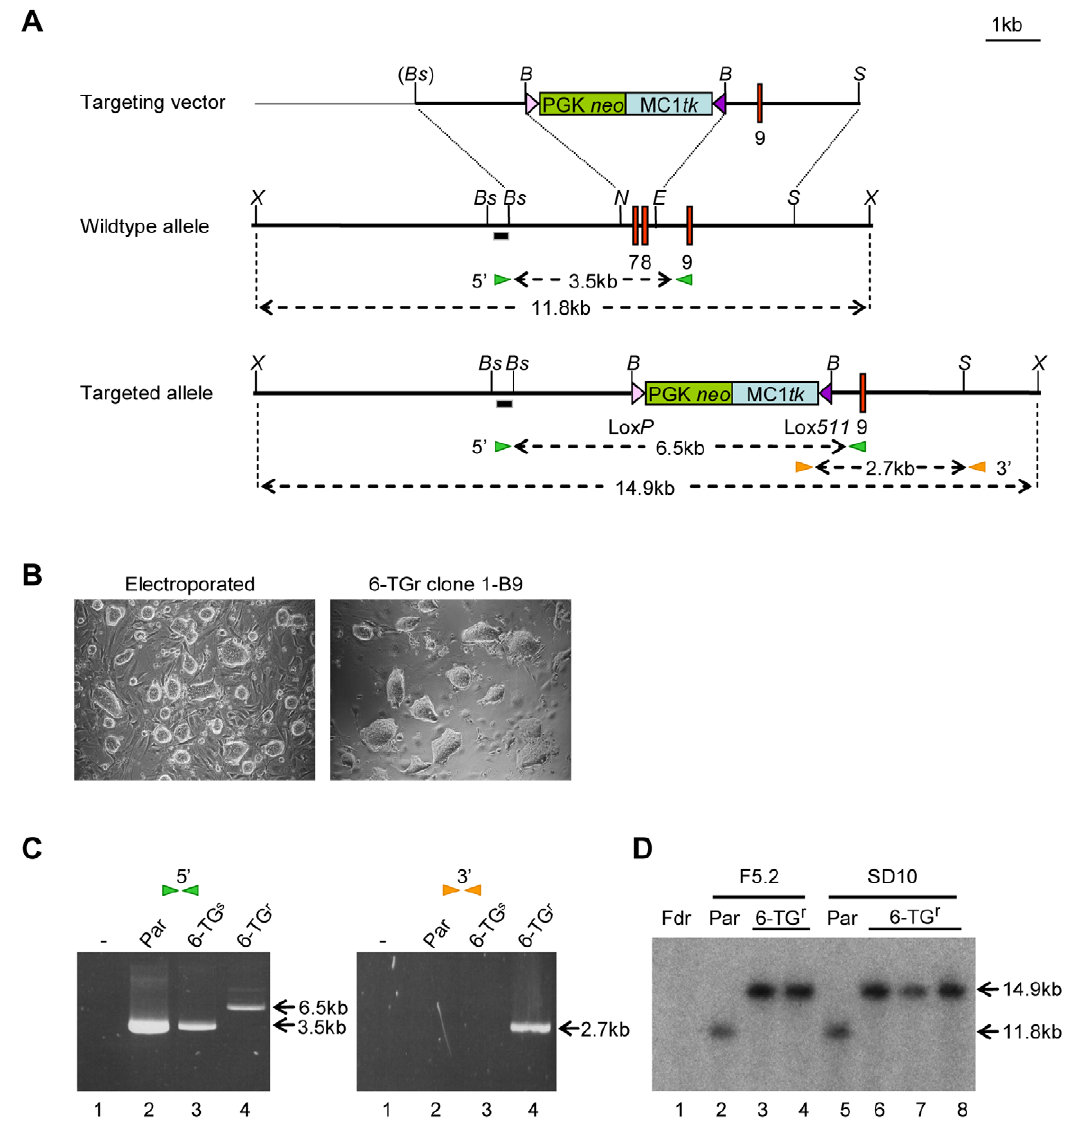
Figure 1. Targeting of the hprt gene in rat embryonic stem cells. (A) Structure of the HPRT targeting vector (top), the wild-type hprt allele (middle) and targeted allele (bottom), resulting from replacement recombination at the dotted lines. The null allele was created by substitution of exons 7 and 8 with a PGK neo / MC1tk selection cassette (green and blue boxes). Exons are depicted by red boxes, non-exon–containing chromosomal, and cloned, genomic DNA sequence is shown by a thick black line and pBluescript plasmid sequence by a thin black line. Restriction enzyme sites BamHI ( B ) BstBI ( Bs ), Eco RV ( E ), Nde I ( N ), Sac I ( S ) and Xba I ( X ) are indicated. Oligonucleotide pairs (green and orange arrowheads) and 5 9 probe sequence (hashed box), consisting of sequence homologous and external to the homology arms, were used for PCR-based and Southern screening respectively. Sizes of expected products are shown by dotted arrows. (B) Brightfield image of electroporated RIF5.2 cells two days post- electroporation and prior to selection (left panel), and of a resultant 6-TG-resistant clone 1-B9 (right panel) (Magnification x100). (C) Confirmation of targeted integration by PCR amplification of (1) water blank, and of genomic DNA from (2) RIF5.2 parental rat ES cell line, (3) 6-TG-sensitive wildtype clone and (4) 6-TG-resistant targeted RIF5.2 clone using oligonucleotide pairs shown in (A). (D) Confirmation of targeted integration by Southern blot analysis using 5 9 probe shown in panel (A), of XbaI digested genomic DNA from (1) SNL feeder cells, (2) RIF5.2 parental rat ES cell line, (3) RIF5.2- derived 6-TG-resistant clone 1-B9, (4) RIF5.2-derived 6-TG-resistant clone 3-B4, (5) RISD10 parental cell line, (6) RISD10-derived 6-TG-resistant targeted clone 13, (7) RISD10-derived 6-TG-resistant targeted clone 14 and (8) RISD10-derived 6-TG-resistant targeted clone 16. doi:10.1371/journal.pone.0014225.g001 ICMs and passaged cell lines were plated on DIA-M feeders Monolayer neural differentiation was induced by adherent serum-free culture for 11 days using laminin as a substrate for in 2i medium [2]. Inhibitors were custom-synthesized by the attachment. Division of Signal Transduction Therapy, University of Dundee. Cell lines were routinely passaged by aspirating the DNA Cloning colonies into fine, glass pipettes and transferring the resultant disaggregated cells to fresh wells or by dissociation with Cell A 6.9 kb fragment was amplified from F344 genomic DNA using oligonucleotides flanking Exons 7, 8 and 9 (HPRTintr6for2 - Dissociation Buffer.